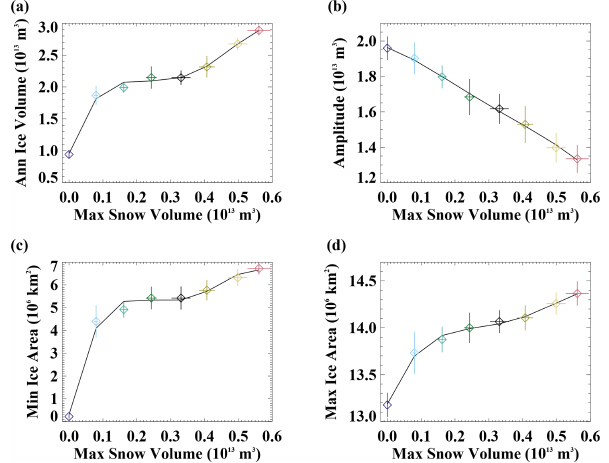
Figure 4. The relationship of the climatological Northern Hemi- sphere (a) annual ice volume, (b) amplitude of the ice volume an- nual cycle, (c) annual minimum ice area, and (d) annual maximum ice area versus the annual maximum snow volume. The diamonds show the simulated mean values, and whiskers are ± 1 standard de- viation across the 20 years analyzed for each simulation. The colors are the same as in other figures. The black line is a fourth-order polynomial fit.